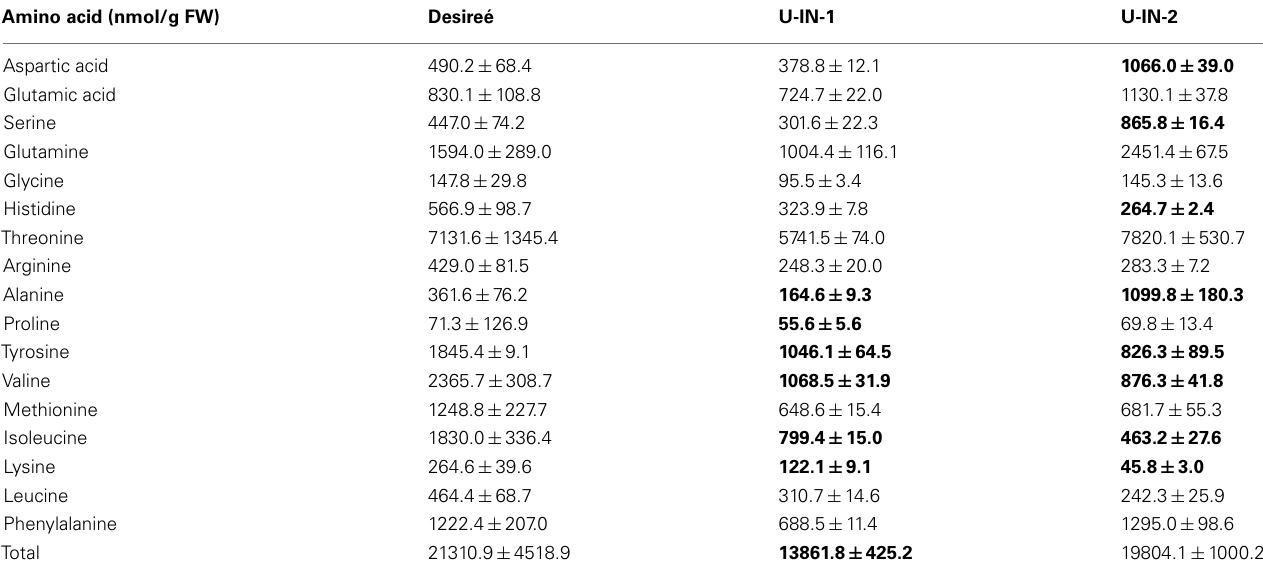
TableA2 |Amino acid content of the different